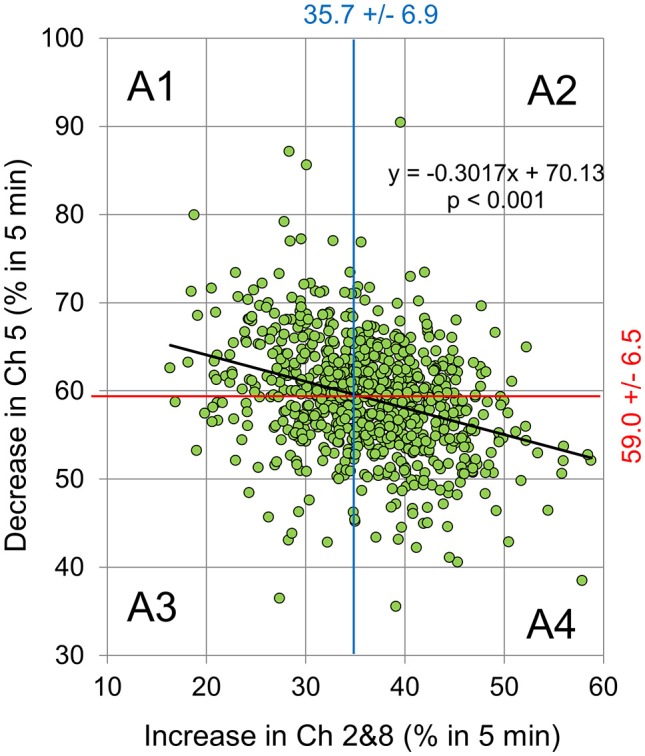
The relationship between decreased Ch 5 signal and simultaneously increased Ch 2 and 8 signals during the 5-min experiment for individual subjects. The changes were expressed as % of decreased (or increased) duration for 5 min (i.e., a decrease or increase for 5 min denotes 100%). There was a weak, but significant, correlation between the decrease at Ch 5 and the increase at Chs 2 and 8 (Y = −0.3017 *
X + 70.13, R2 = 0.1041, p < 0.001). The vertical blue and horizontal red lines represent mean values of the changes in the increased Ch 2 and 8 signals (35.7% +/− 6.9 S.D.), as well as those of the decreased Ch 5 (59.0% +/− 6.5 S.D.). Here, the areas divided by these lines were classified as: Area 1 (A1: Y > 59.0 and X < 35.7%); Area 2 (A2: Y > 59.0 and X > 35.7%); Area 3 (A3: Y < 59.0and X < 35.7%); and Area 4 (A4: Y < 59.0 and X > 35.7%).